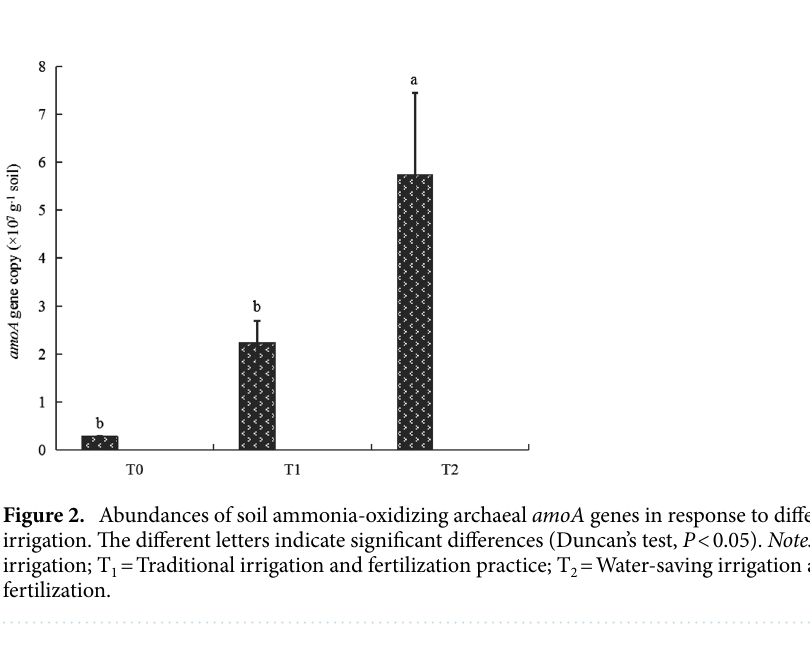
Table 2. Soil chemical properties and potential ammonia oxidation as influenced by fertilization and irrigation in 2018. T 0 = Traditional irrigation; T 1 = Traditional irrigation and fertilization practice; T 2 = Water- saving irrigation and optimizing fertilization. SOC: soil organic carbon; N: nitrogen; TN: total N; NO 3- —N: nitrate N; NH 4+ —N: ammonium N; PAO: potential ammonia oxidation. Values (means ± SD) with different lower-case letters in a column are significantly different at P < 0.05 according to the Duncan test.